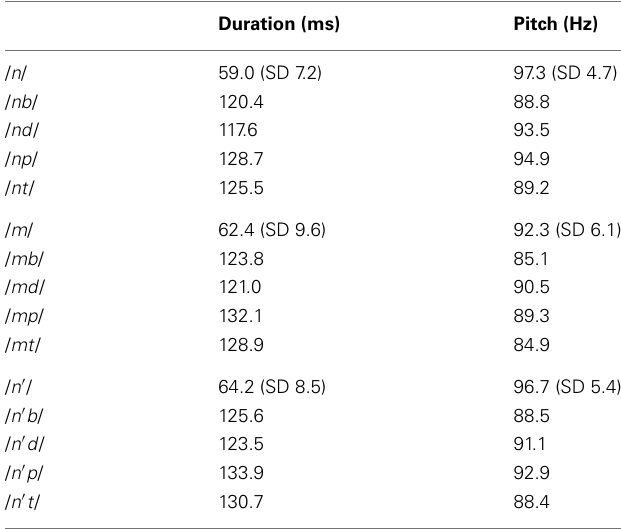
Table 1 | Mean duration (in ms) and pitch (Hz) of the single nasal and nasal/ + context